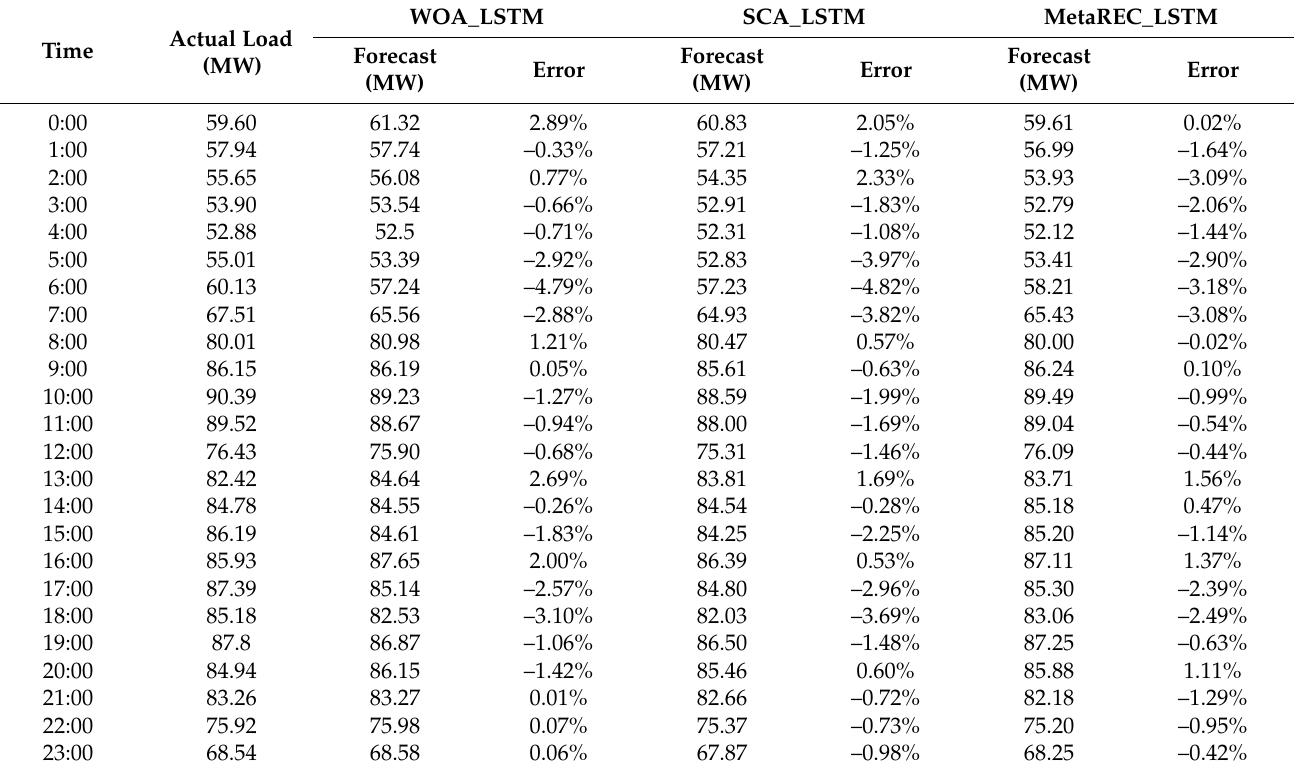
Table 4. Comparison of results from multiple prediction